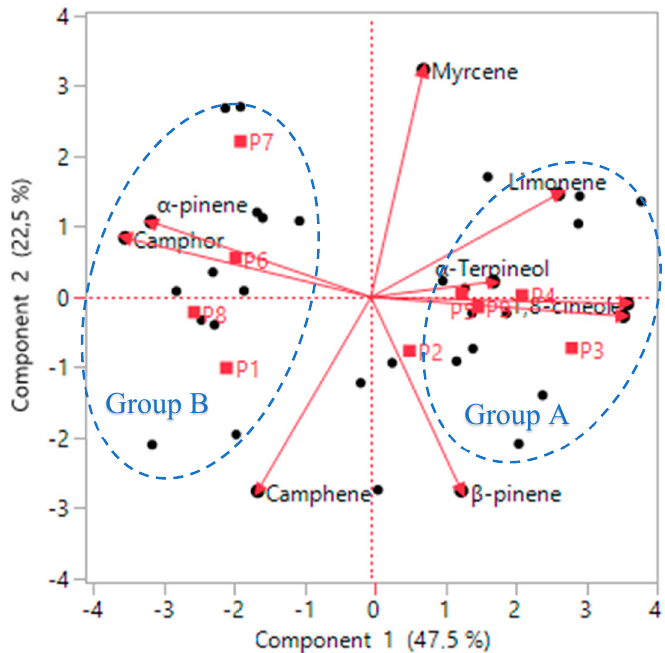
Figure 4. Biplot of variables and individuals in the factorial design. Pn: period of harvesting. Group A represents the summer season. Group B represents the winter season.